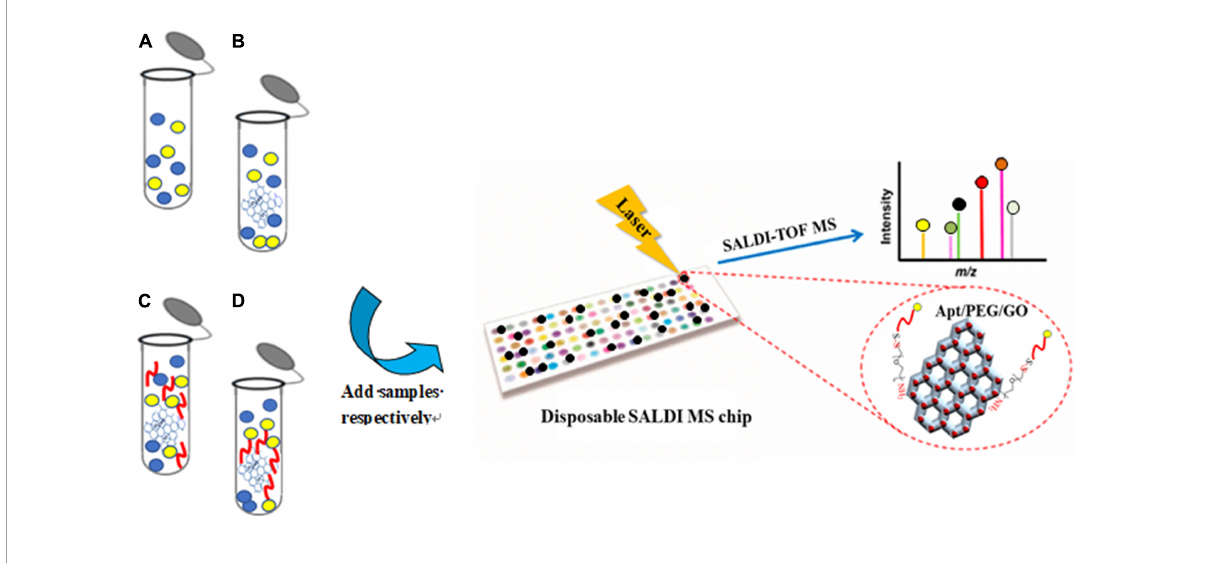
FIGURE3 Schematic analysis of the GO-based aptamer-assisted mass spectrometry analysis. (A) Analysis of analyte ionized on GO without extraction; (B) analysis of analyte extracted with GO and ionized on GO; (C) analysis of analyte extracted with non-covalent-aptamer bound GO and ionized on GO; (D) analysis of analyte extracted with covalent-aptamer bound GO and ionized on GO.